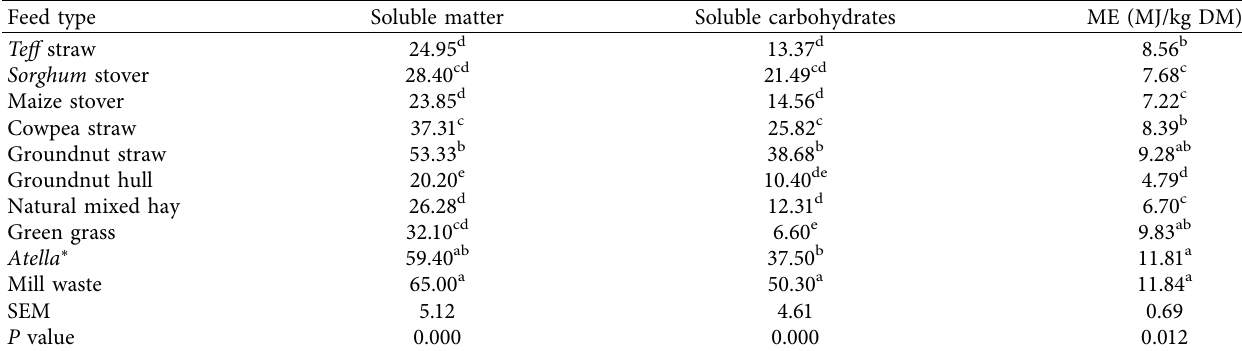
Table 2: Soluble carbohydrates and energy contents of major feed resources (% of DM).